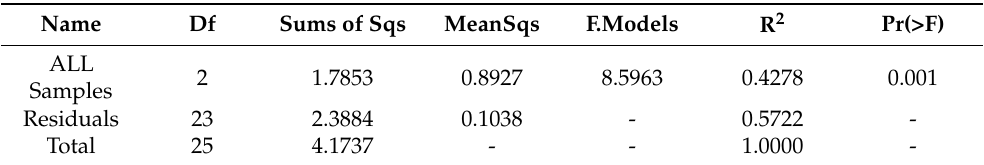
Table A1. Results of the PERMANOVA analysis of the gut microbial diversities among domestic males, domestic females and wild males.